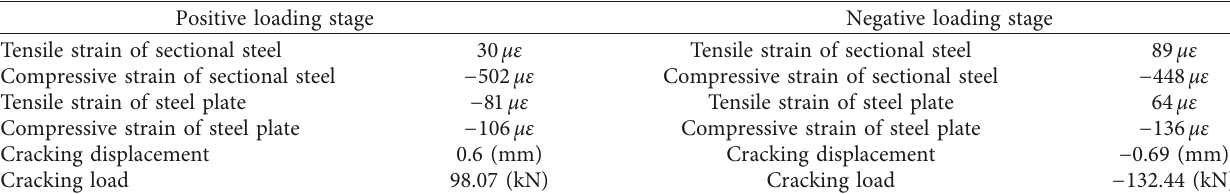
Figure 5: Diagram of cracks in the Δ � 3mm displacement cycle. (a) First cycle. (b) Second cycle. Table 5: Test data of the SPRCW-3 test piece in the load control stage.